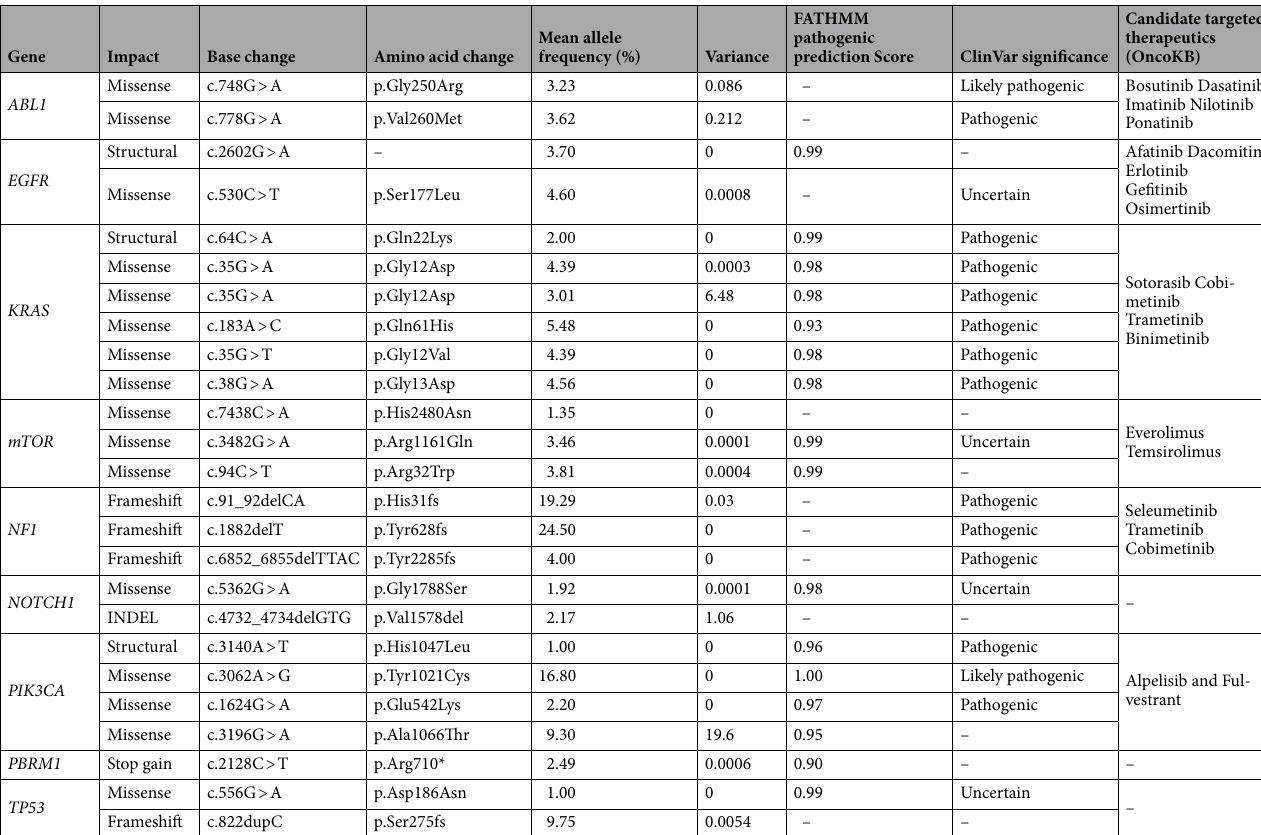
Table 2. Most frequent somatic mutations in the study population (n = 42). Somatic mutations with a tumor variant allele frequency ≥ 1% (and significantly < 50%) together with nucleotide and amino acid changes, FATHMM (functional analysis through hidden Markov models) pathogenic prediction score and National Library of Medicine ClinVar significance are summarized in table. FATHMM is a high throughout webserver capable of predicting functional consequences of coding and non-coding variants. Targeted therapeutics which may serve as candidates for further investigation are derived from the OncoKB